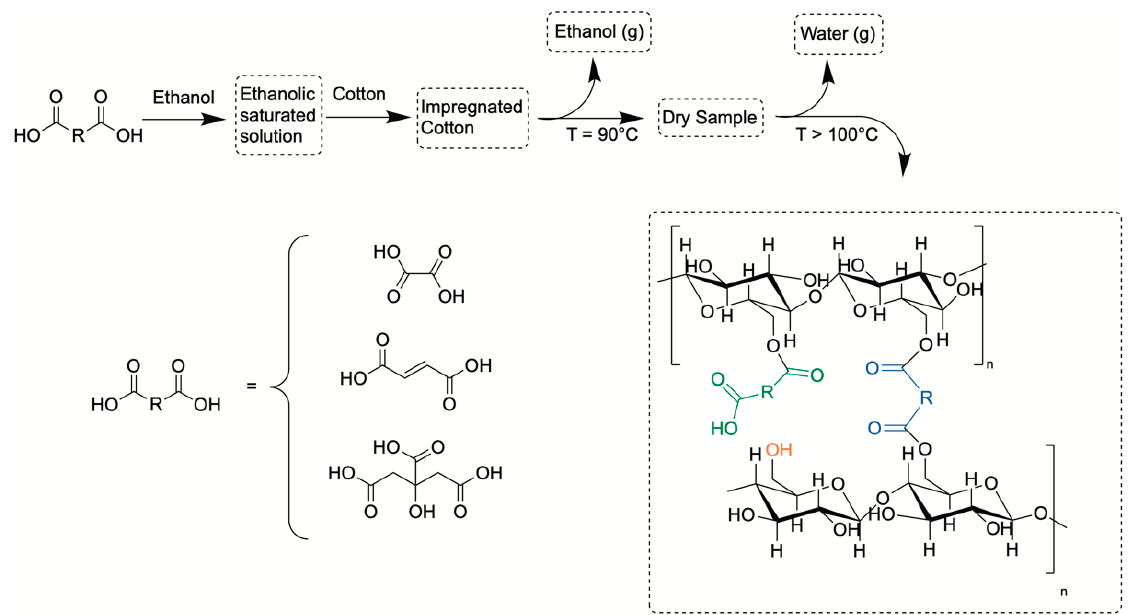
Figure 1. Schema showing the procedure used for cotton modification ( top ). Chemical structure of the polycarboxylic acids used in the proposed method ( bottom - left ). Possible resulting products of the proposed method ( bottom - right ). The green moieties represent the free carboxy groups (FCC), and the blue ones represent the crosslinked groups. Orange moieties correspond to the –OH group from C 6 .